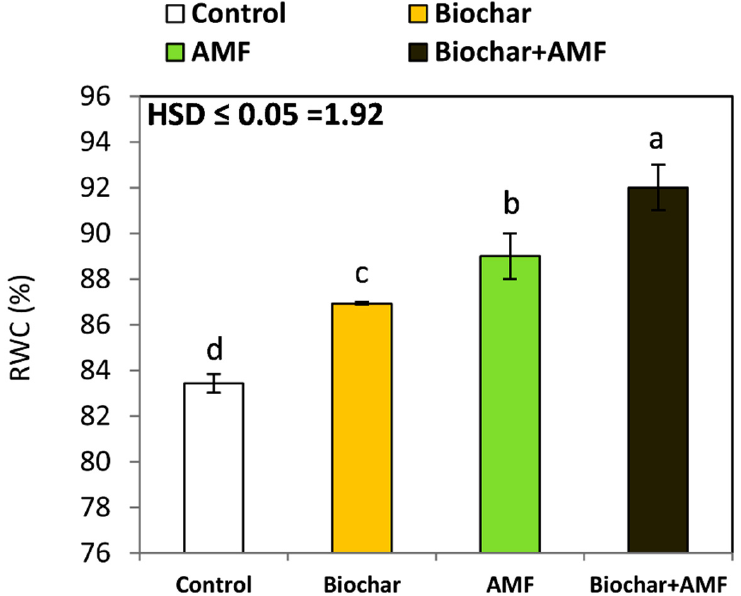
Figure 2. Impact of biochar and AMF on the relative water content of fenugreek leaf. Data are means of five replicates ( n = 5), for each parameter, the mean values ± SD followed by a different letter are significantly different according to Tukey’s HSD range test at p ≤ 0.05 .